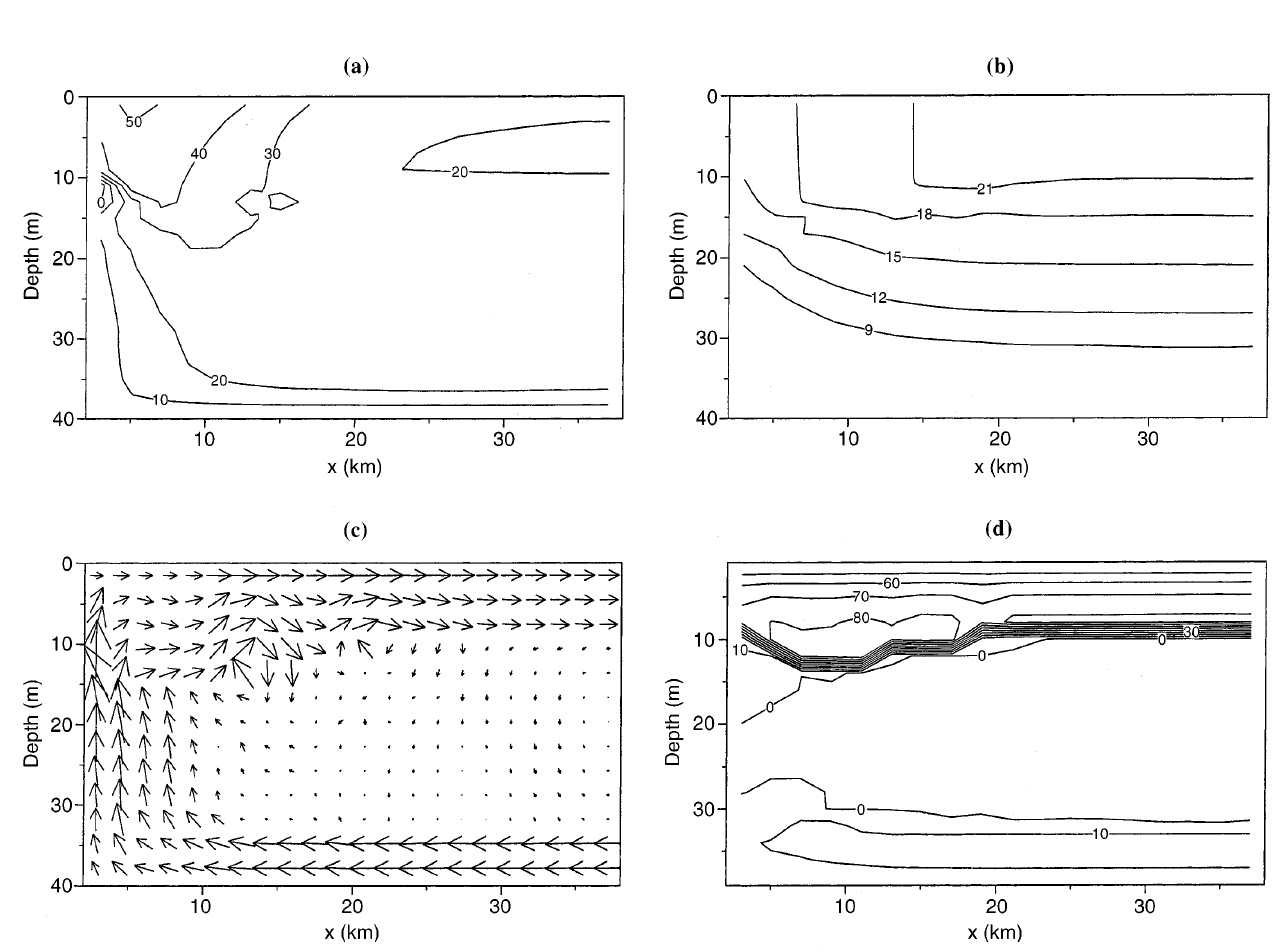
Fig. 8a–d. Solution of the direct simulation used to construct the observation of coastal upwelling at t (cid:136) 48h : x (km) is the distance to the coast. a Velocity v (cid:133) cm (cid:1) s (cid:255) 1 (cid:134) , b Temperature (cid:133) (cid:14) C), c